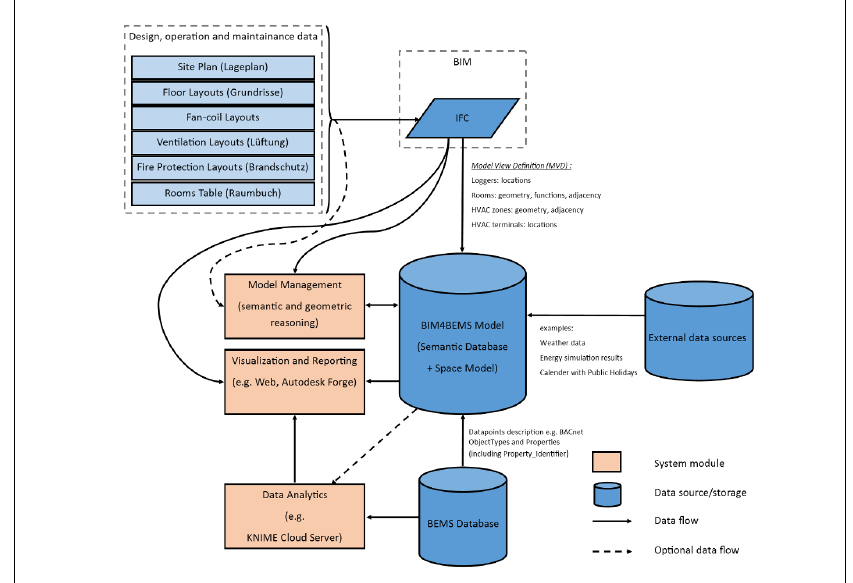
Figure 2: BIM4BEMS system architecture